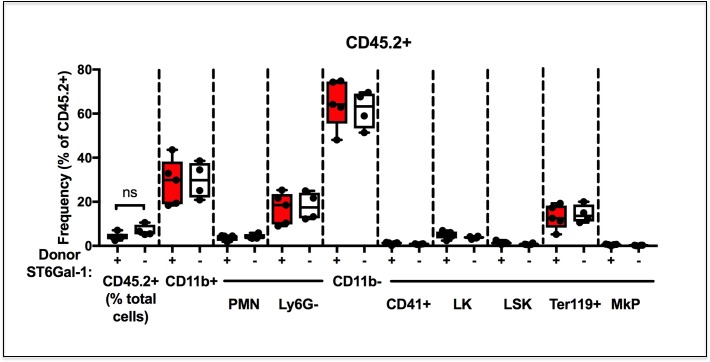
Chimerism of Analyzed CD45.2+ Host cells.Frequency of analyzed CD45.2+ residual recipient cells as a proportion of total BM cells is shown, with relevant cell subsets shown.